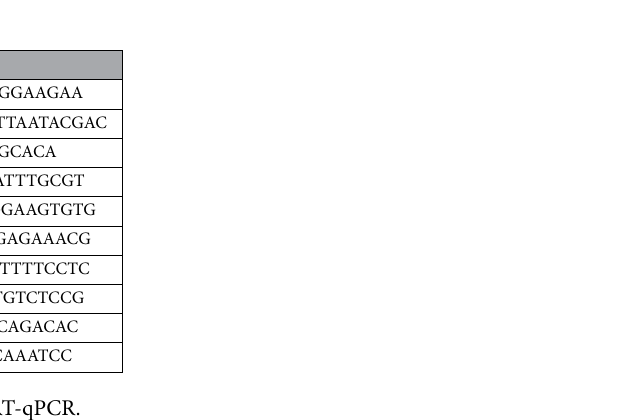
Table 2. The primer sequences for